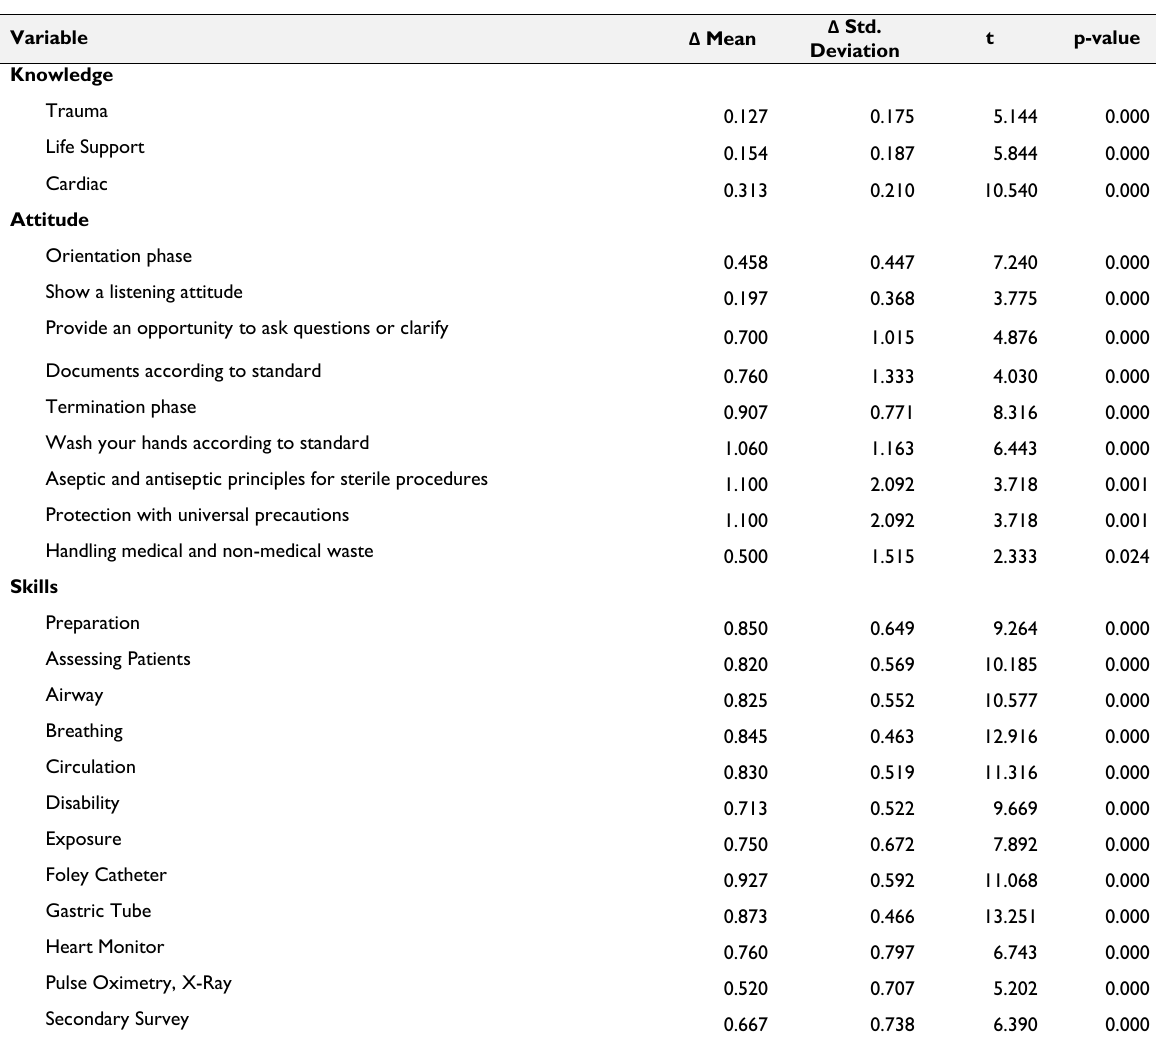
Variable Δ Mean